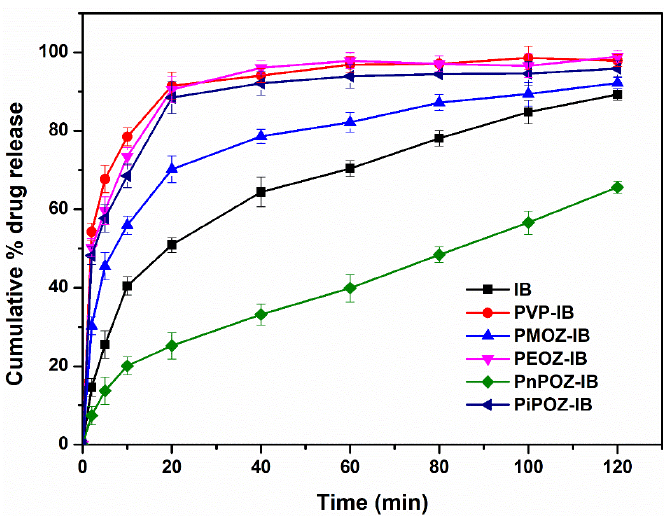
Figure 5. Dissolution profiles of pure IB and from different polymer–IB solid dispersions ((poly- mer repeat unit)/(drug) = 1:1 mol/mol). Cumulative % drug release with standard error of mean has been plotted against time. been plotted against